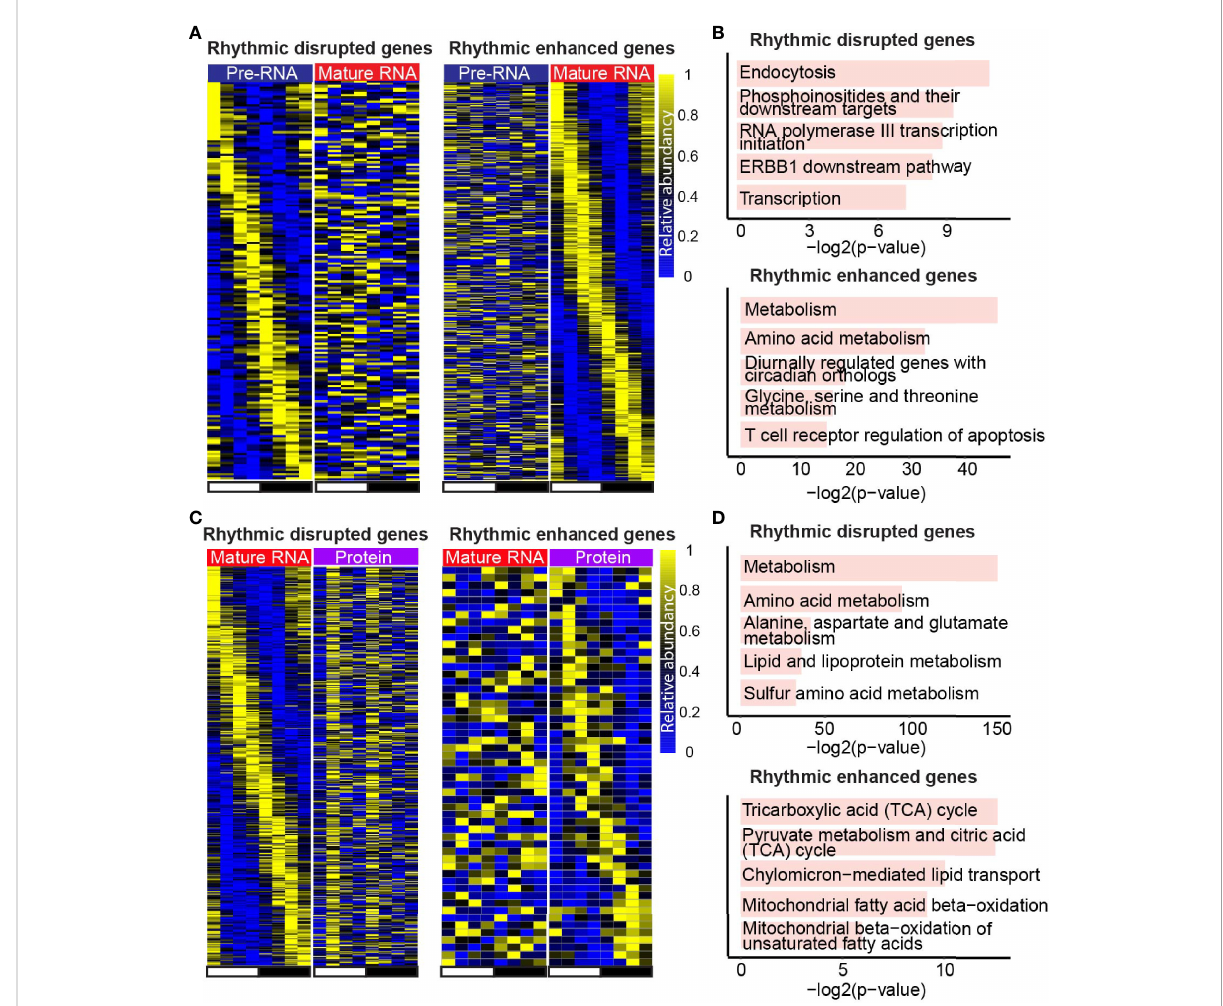
FIGURE 4 Layer-speci fi c rhythmic genes support the layer-speci fi c function. (A, C) Heatmaps show the expression of rhythmic disrupted genes (left panel) and rhythmic enhanced genes (right panel) at mature RNA level compared with transcription (A) , and the ones in protein level compared with mature RNA (C) . (B, D) Bar plots show the enriched pathways of rhythmic disrupted genes (top panel) and rhythmic enhanced genes (bottom panel) in mature RNA level compared with transcription (B) , and the ones in protein level compared with mature RNA (D) . Only genes detected in both adjacent layers were